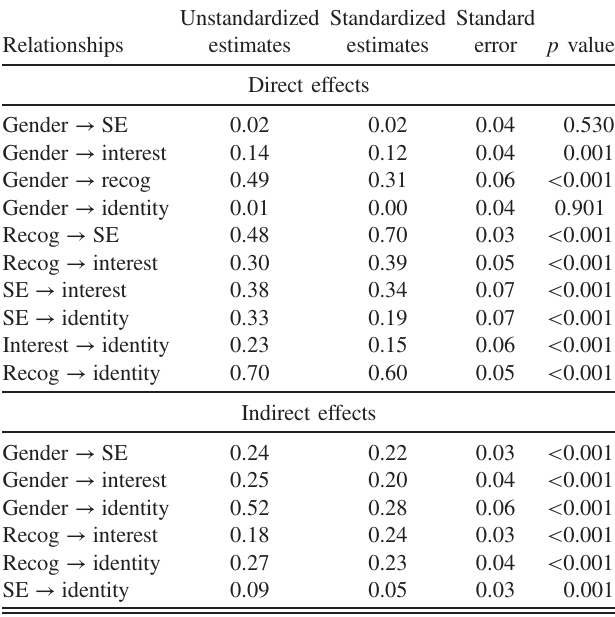
TABLE VII. Results of the path analysis part of SEM model 2 for physics 2. Recog represents perceived recognition. SE represents self-efficacy. Single-headed arrows represent direct or indirect regression